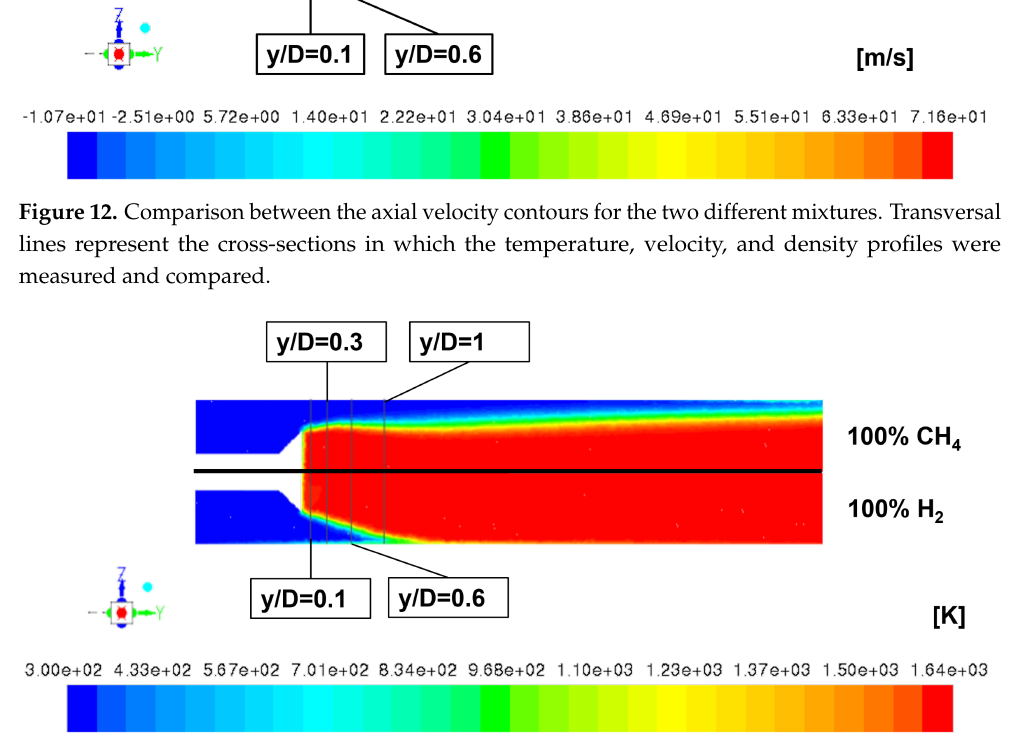
Figure 13. Comparison between the temperature contours for the two different mixtures. Transversal lines represent the cross-sections in which the temperature, velocity, and density profiles were